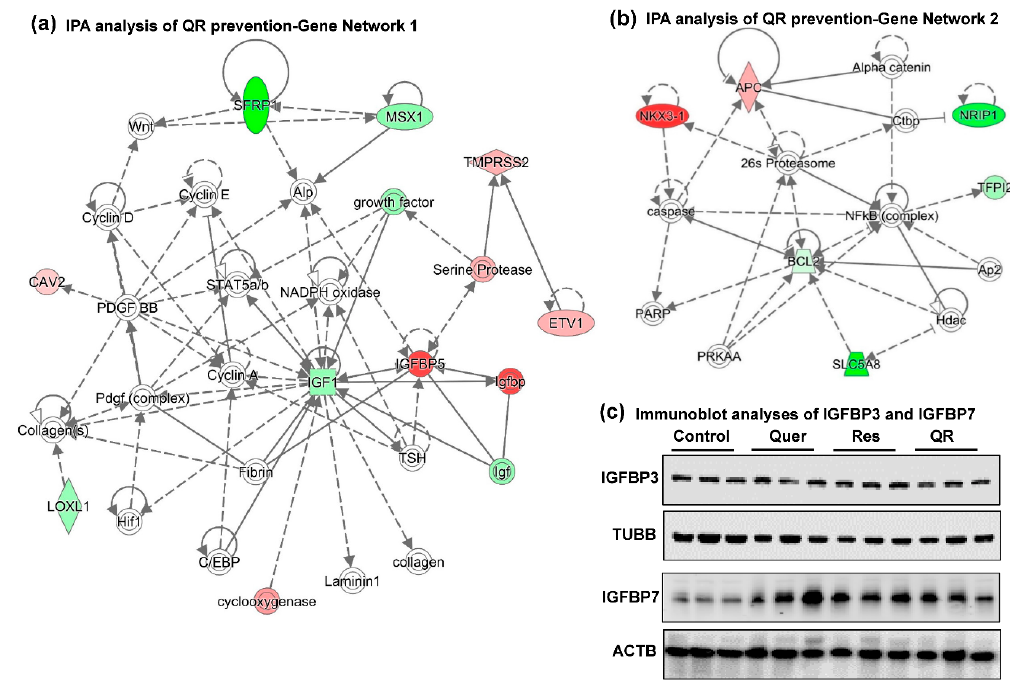
Figure 5. Gene networks analysis of quercetin–resveratrol modulated genes suggest IGF1 and BCL2 as key signaling nodes associated with anti-PCa effects. Differentially expressed genes from PCa PCR array with cut-off criteria of ≥ 2-fold change in any one treatment group with statistically significant change ( p < 0.05), and ≥ 1.5-fold change in any other group (total 22 genes) were uploaded in Ingenuity Pathway Analysis (IPA) software. ( a ) Gene network 1 indicating IGF1 inhibition as a key player interacting with most of the genes in the network. ( b ) Gene network 2 indicating BCL2 inhibition as another important player interacting with most of the genes in the network. Red indicates upregulated genes, green indicates downregulated genes, and uncolored nodes indicate genes not included in the PCR array but appeared during IPA analysis to connect the genes of the network. Solid lines indicate robust interactions, whereas dashed lines are significant but less frequent. ( c ) Immunoblot analyses of IGFBP3 and IGFBP7 proteins. TUBB and ACTB were used as a loading control.